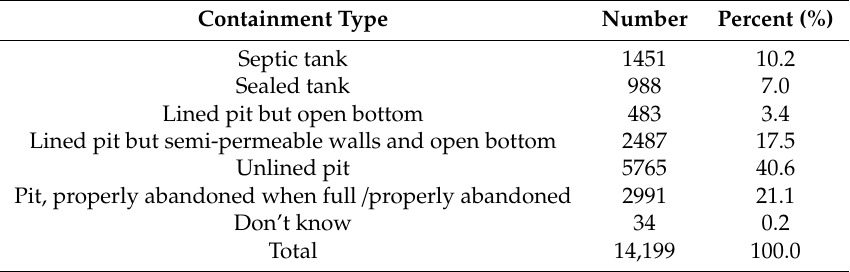
Table 3. Types of sanitation